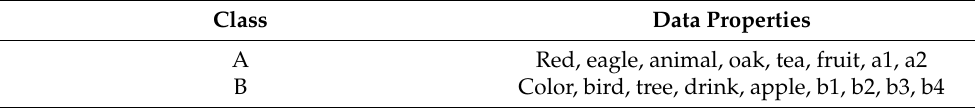
Table 8. Data properties of classes A and B from example 2.